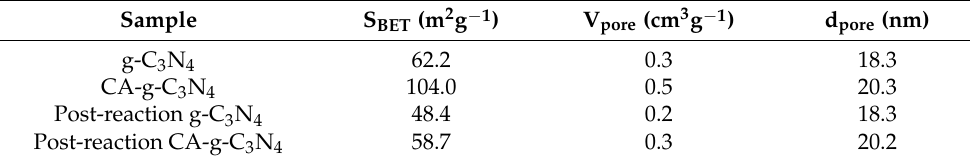
Table 1. Comparison of specific surface area, pore volumes and pore sizes.